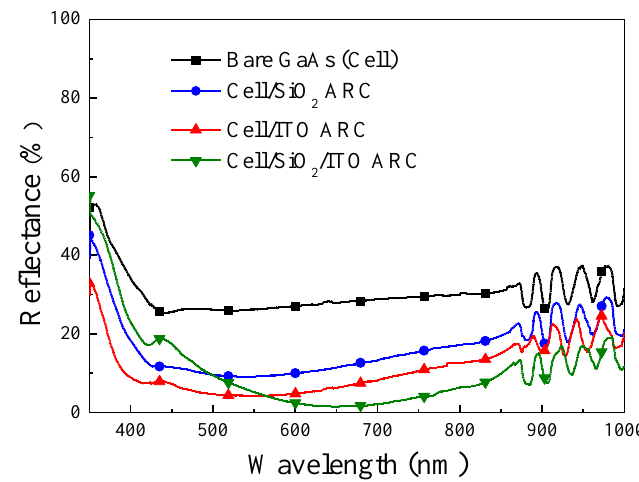
Figure 6. Optical reflectance of bare GaAs solar cell, GaAs cell with SiO 2 ARC, GaAs cell with ITO ARC, and cell with thin-SiO 2 /ITO ARC.